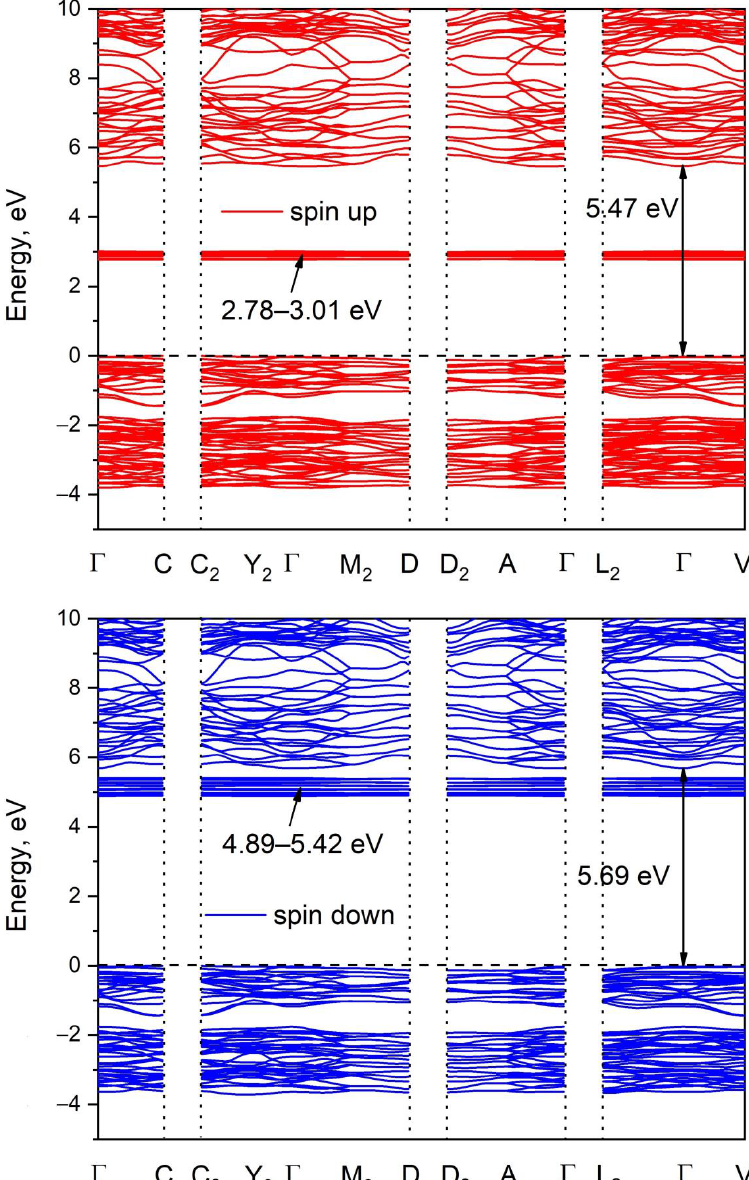
Figure 5. Calculated band structure of Pr 2 (SO 4 ) 3 . The lower panel is for spin up and the upper panel is for spin down.